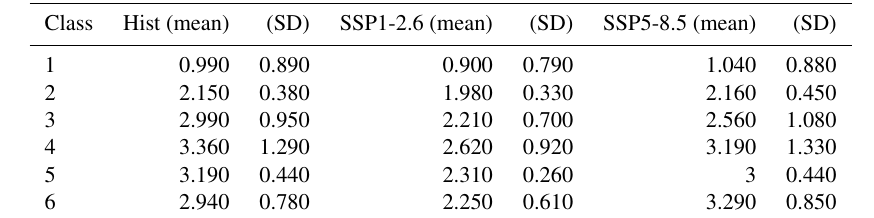
Table 1. Ozone concentration statistics at 850hPa for the historical, SSP126, and SSP585 experiments (shown in mPa) (from Fig. 2 but for each experiment).